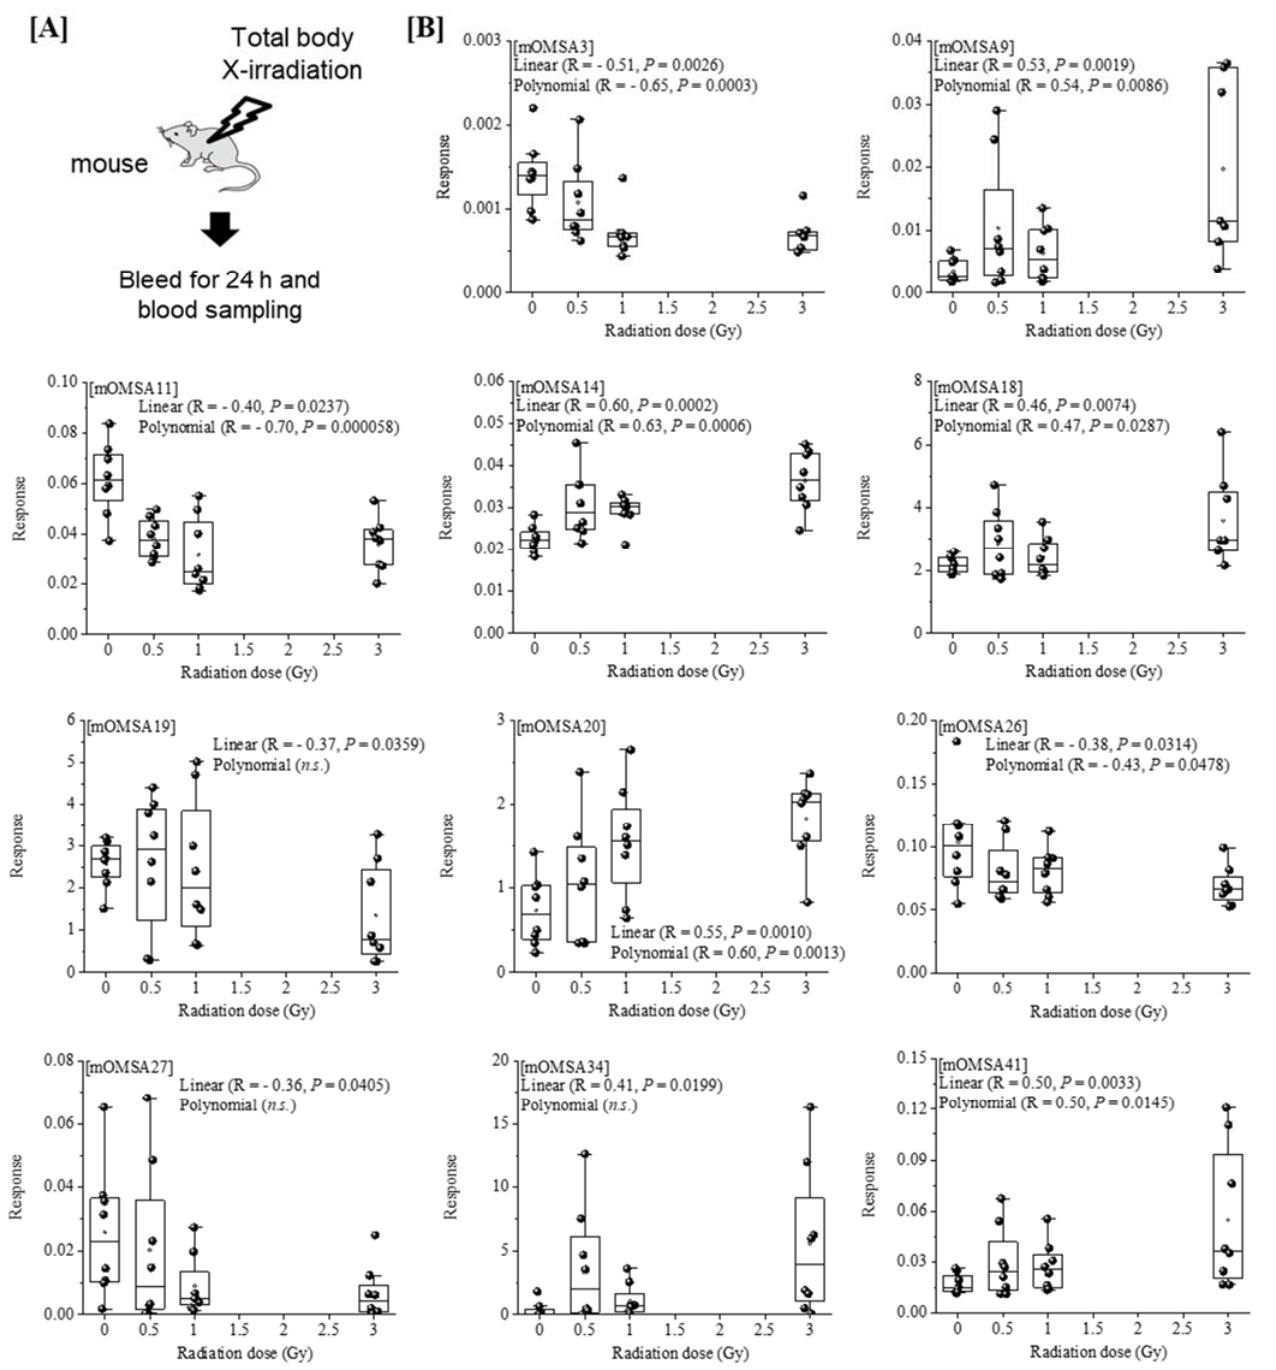
Figure 3. Correlation between the oxidative modification sequence of MSA with single TBI and the radiation dose in vivo model. [ A ] Eight ‐ week ‐ old female C57BL/6JJcl mice were exposed to varying TBI doses of 0, 0.5, 1 or 3 Gy of X ‐ rays. Peripheral blood was harvested 24 h after TBI from the orbital venous plexus of mice (in vivo model). [ B ] Eleven sequences that showed significant dose ‐ dependent correlations by linear or curve fitting are shown. Five sequences (mOMSA3, mOMSA9, mOMSA14, mOMSA20 and mOMSA41) showed a correlation coefficient ( r value) of >0.5. p values of <0.05 were considered statistically significant.